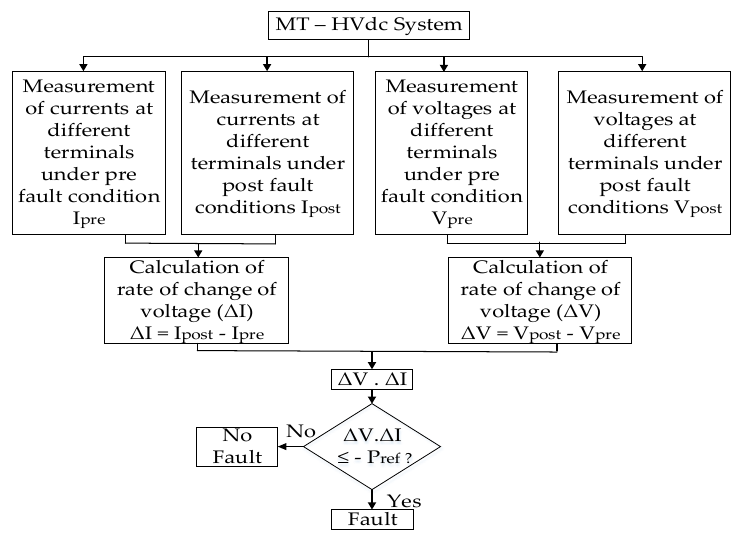
Figure 27. Non-traveling wave (NTW) method based on transient values in multi-terminal high-voltage direct current (MT–HVdc) system.